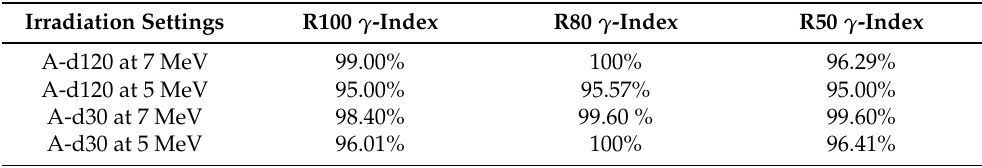
Table 6. Gamma index analysis for transverse dose profiles at R100, R80, and R50, performed with 3% 3 mm